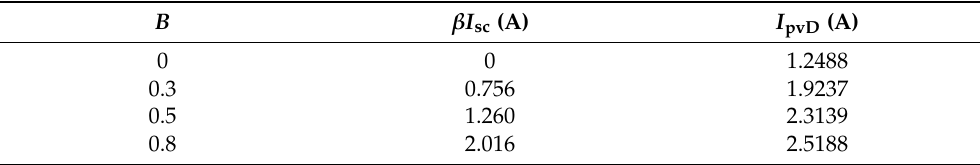
Table 1. Boundary value of three working states of faulty module.